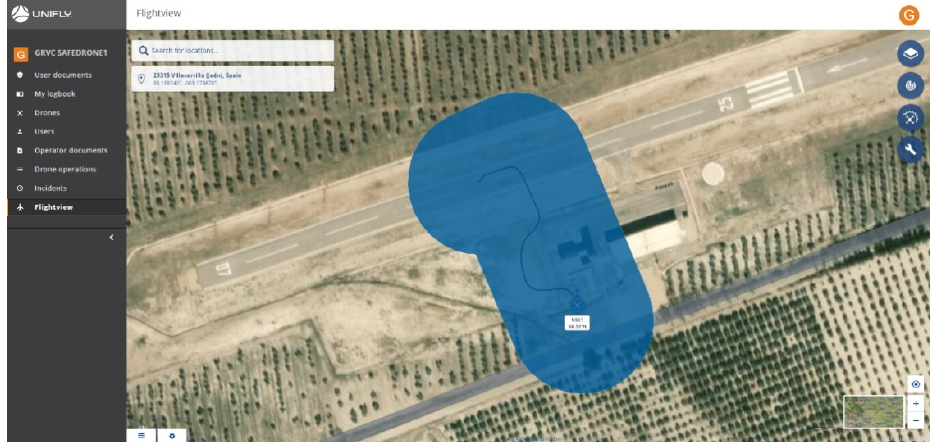
Figure 17. Image from Unifly USP showing the final trajectory performed by the drone and the whole area reserved in the U-space system.